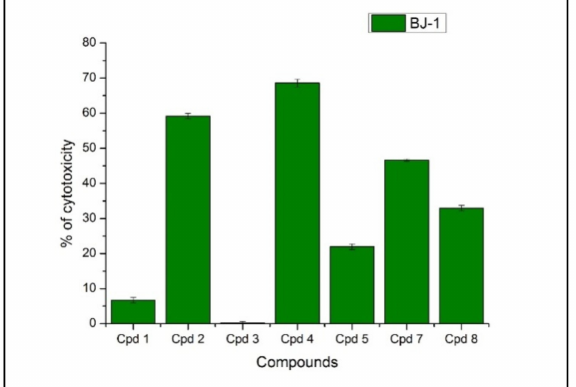
Figure 4. Cytotoxic activity of the newly synthesized GA peptides against the normal skin human cell line BJ-1 at 10